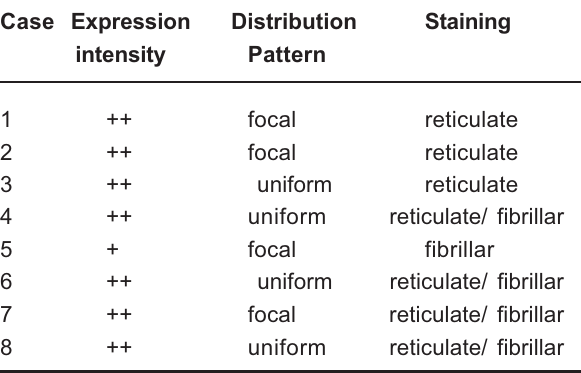
Source: Postgraduate Program in Oral Pathology of UFRN.